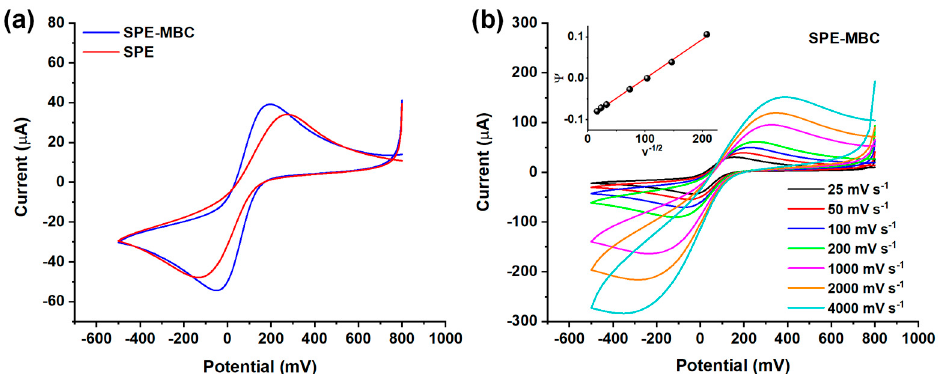
Figure 6. ( a ) Cyclic voltammograms for the ferricyanide/ferrocyanide couple (scan speed = 50 mV/s) obtained using the bare and BC-modified SPE. ( b ) Cyclic voltammograms for the ferricyanide/ferrocyanide couple at different scan speeds (25–4000 mV/s range) obtained using SPE-MBC. Inset: linearization for k 0 calculation.